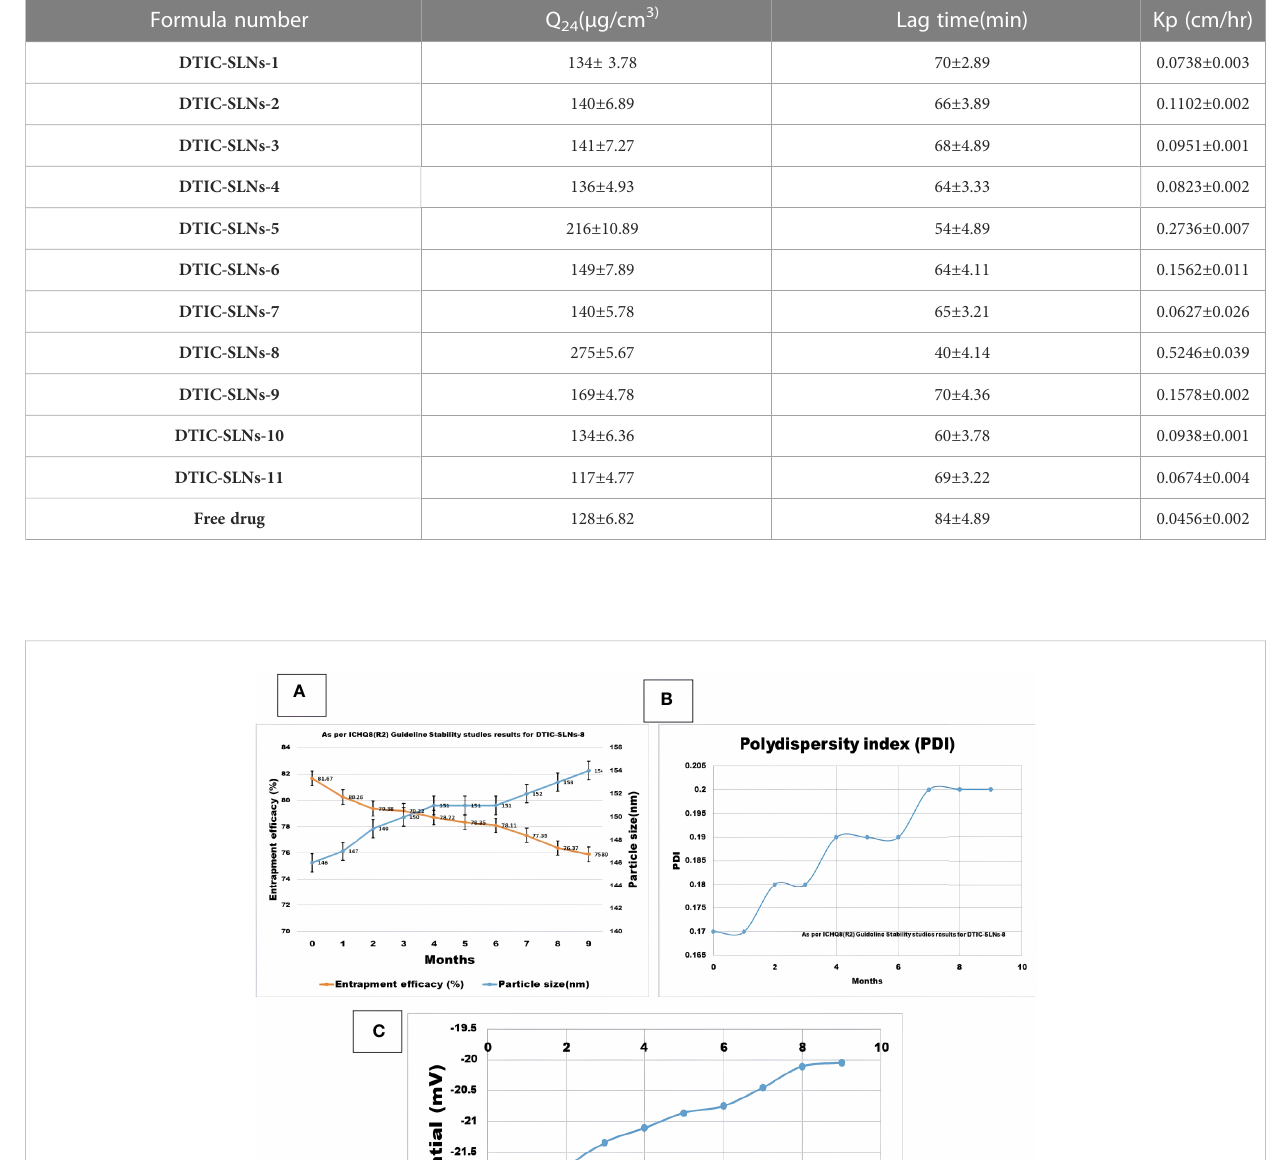
TABLE 3 The permeation parameters of different SLN formulas compared to the free drug (mean ± SD,